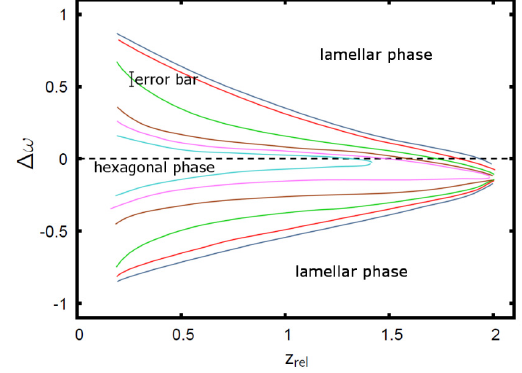
( d ) Figure 5. Phase diagram of the Phase diagram of the AB + A + B polymer blend: The colored curves denote the polymer blend: The colored curves denote the phase boundaries between the hexagonal phase on the inside (small phase boundaries between the hexagonal phase on the inside (small ) and the lamellar phase on the outside. Phase boundaries are shown for phase on the outside. Phase boundaries are shown for (dark blue), (dark blue), (red), (green), (brown), (magenta), (cyan) Reproduced with permission from Thomas Gruhn, Heike Emmerich polymer blends with reversible crosslinks